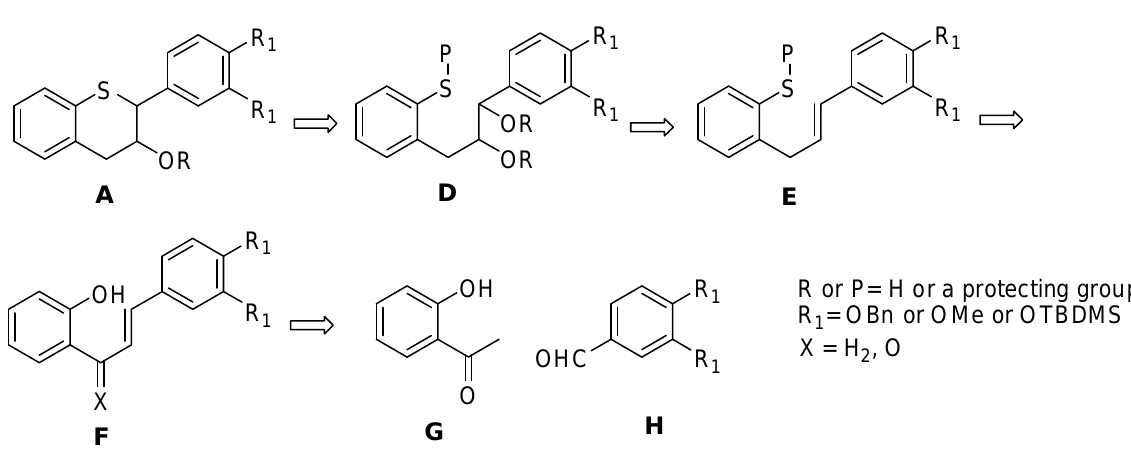
Figure 4. Modified retrosynthetic